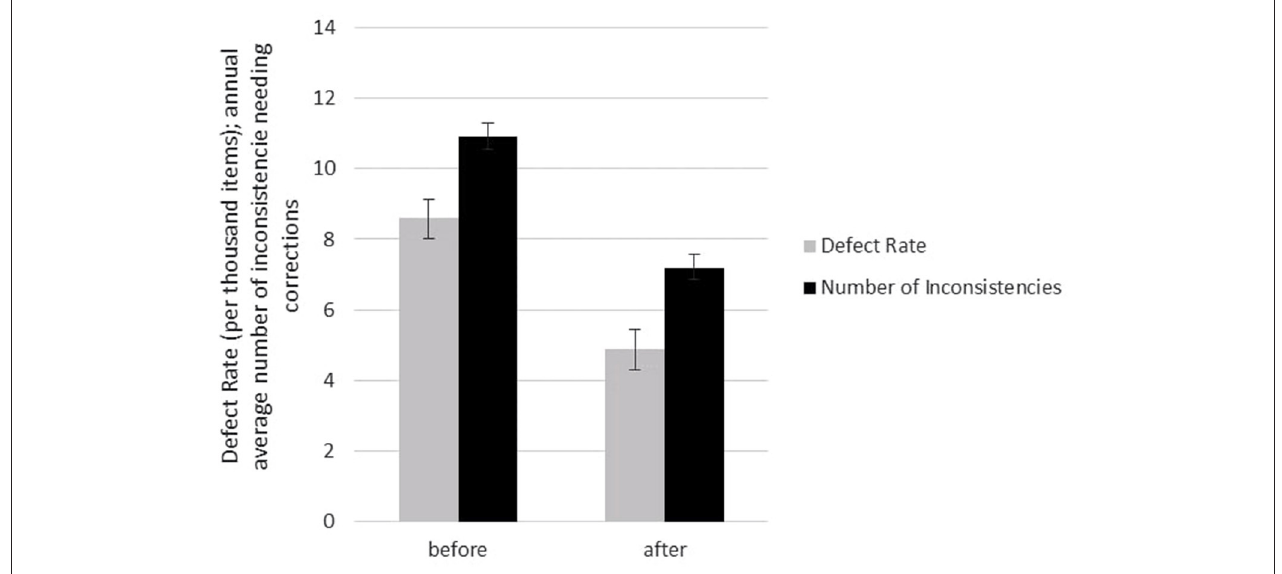
FIGURE 6 | The changes in the product defect values and the amount of process flow inconsistencies needing improvement (before and after implementation of ISO